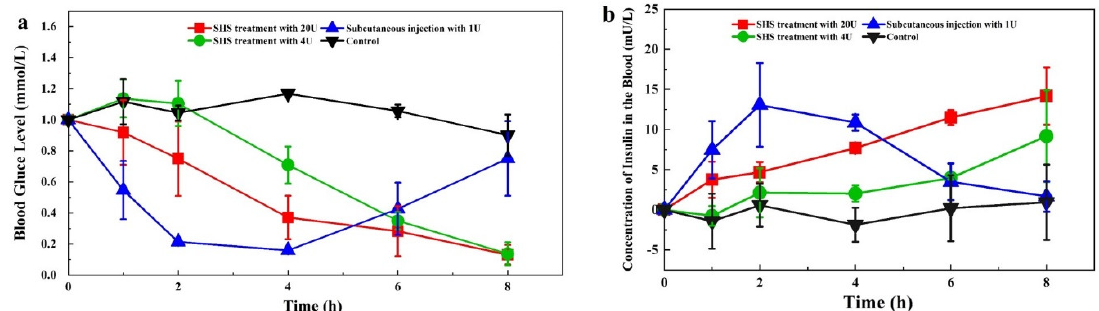
Figure 5. The blood glucose level (BGL) profiles and plasma insulin level (PIL) profiles induced by different treatment strategies in vivo. ( a ) BGL profiles in diabetic rats. ( b ) PIL profiles in diabetic rats.